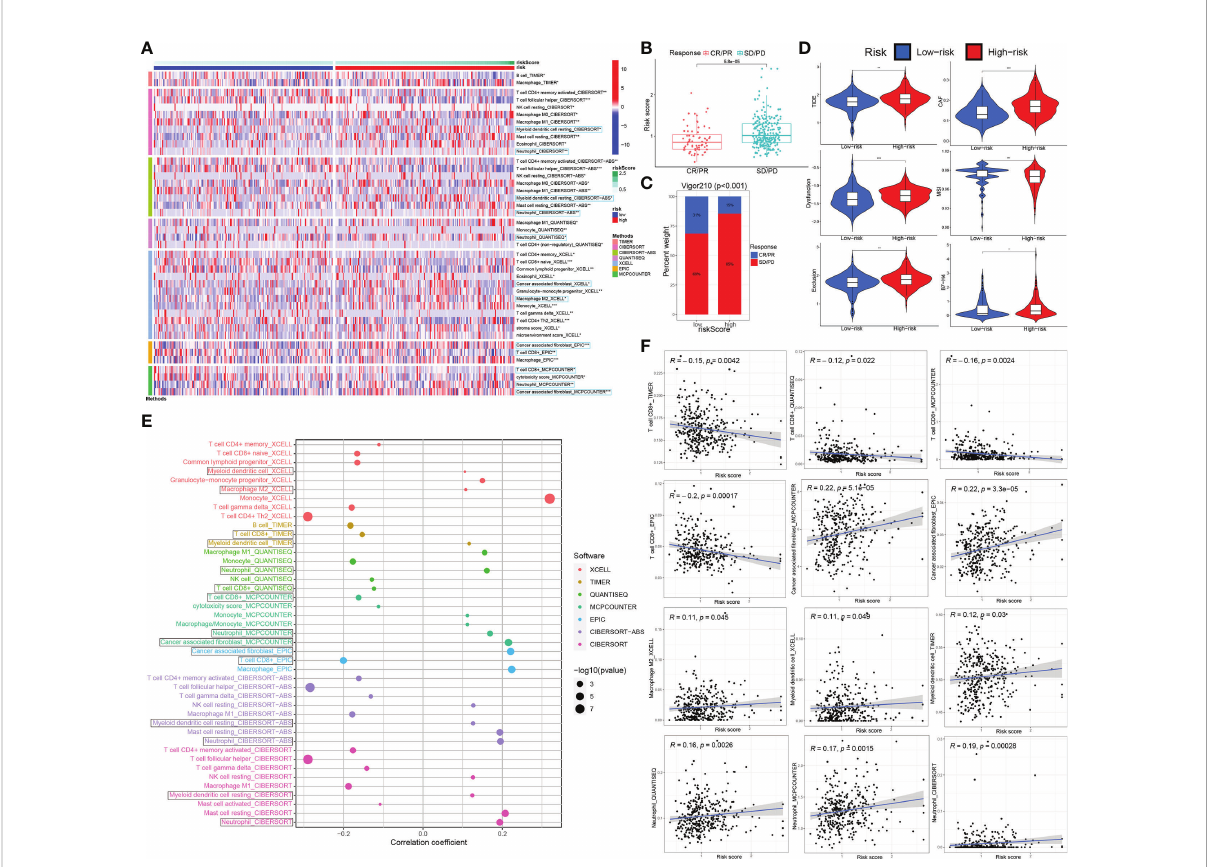
FIGURE 8 The ceRNA-associated gene signature is an important indicator of immune cell in fi ltration and immunotherapeutic effect. (A) The immune cell in fi ltration difference from 7 immune-in fi ltration algorithm in high-risk groups compared to low-risk groups. (B) The association between the risk score and immunotherapy outcome by wilcox test. (C) Correlations among the riskscore group and immunotherapy outcome variables. (D) Using TIDE algorithm analysis and the expression of partial immune checkpoint genes, immune checkpoint blockade therapy response based on riskscore was predicted. (E, F) Spearman association analysis between riskscore and immune cell in fi ltration was implemented. ceRNA, competing endogenous RNA; TIDE, tumor immune dysfunction and exclusion. *P < 0.05, **P < 0.01 and ***P <